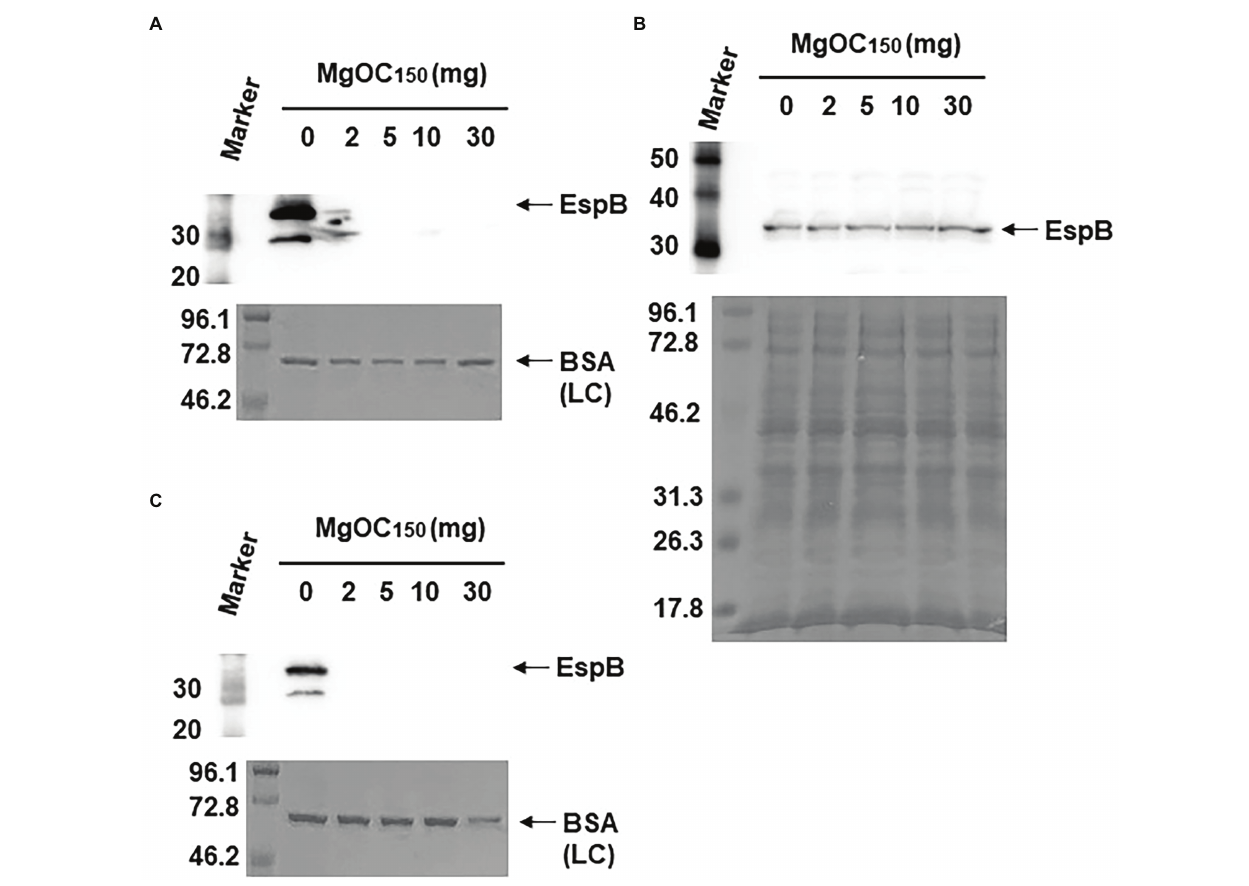
FIGURE 3 | Determination of EspB levels. (A) EspB levels in the EHEC supernatant cultured with and without MgOC 150 . (B) EspB levels in EHEC whole-cell extracts cultured with and without MgOC 150 . (C) The EHEC supernatant was incubated with and without MgOC 150 for 2 h, and EspB levels were estimated after